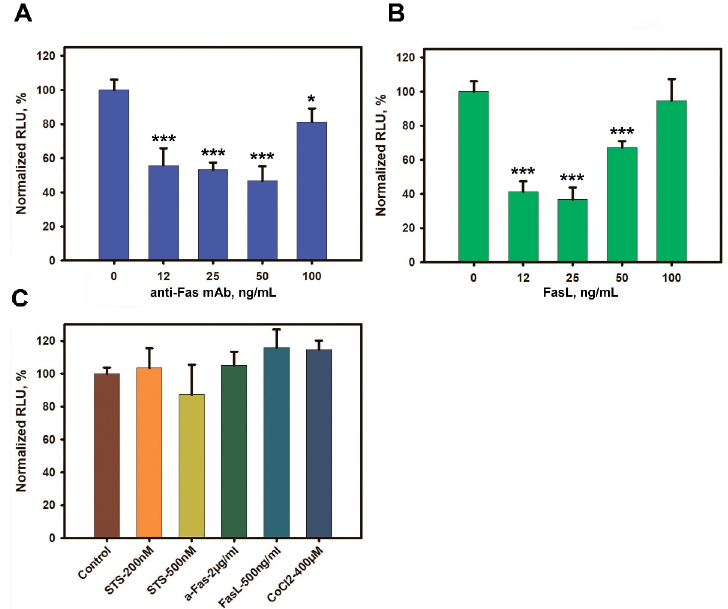
Curr. Issues Mol. Biol. 2022 , 2 , FOR PEER REVIEW 10 Figure 4. Effect of cell death inducers on the ATP levels in L ‐ MSCs. L ‐ MSCs were incubated with Figure 4. Effect of cell death inducers on the ATP levels in L-MSCs. L-MSCs were incubated with low low concentrations of anti ‐ Fas mAb ( A ), FasL ( B ) (0–100 ng/mL), and high concentrations of cell death inducers ( C ) for 4 h. The level of ATP is presented as relative light unit (RLU) values normal ‐ concentrations of anti-Fas mAb ( A ), FasL ( B ) (0–100 ng/mL), and high concentrations of cell death TNF ‐α alone at a concentration of 20 ng/mL did not induce cell death in any of the ized to the control cells, where the luminescence of the control cells is taken as 100%. Averaged three patient ‐ derived L ‐ MSC cultures. Pretreatment of L ‐ MSCs with TNF ‐α and anti ‐ Fas inducers ( C ) for 4 h. The level of ATP is presented as relative light unit (RLU) values normalized to combined data from three patient ‐ derived L ‐ MSC cultures are shown. * p < 0.05, *** p < 0.001. mAb or FasL also did not result in cell death (Figure 5). These data may indicate that even the control cells, where the luminescence of the control cells is taken as 100%. Averaged combined under inflammatory conditions, human L ‐ MSCs do not become sensitive to Fas ‐ induced Despite that all three patient ‐ derived L ‐ MSC cultures were resistant to the induction data from three patient-derived L-MSC cultures are shown. * p < 0.05, *** p < 0.001. apoptosis. of cell death through CD95, a number of changes, such as depolarization of mitochondria and decrease in ATP levels after their treatment with anti ‐ Fas mAb or FasL, occurred, probably indicating the initiation of physiologically significant processes. 3.5. Pro ‐ Inflammatory Cytokine TNF ‐α Does Not Increase the Sensitivity of L ‐ MSCs to Fas ‐ Induced Cell Death